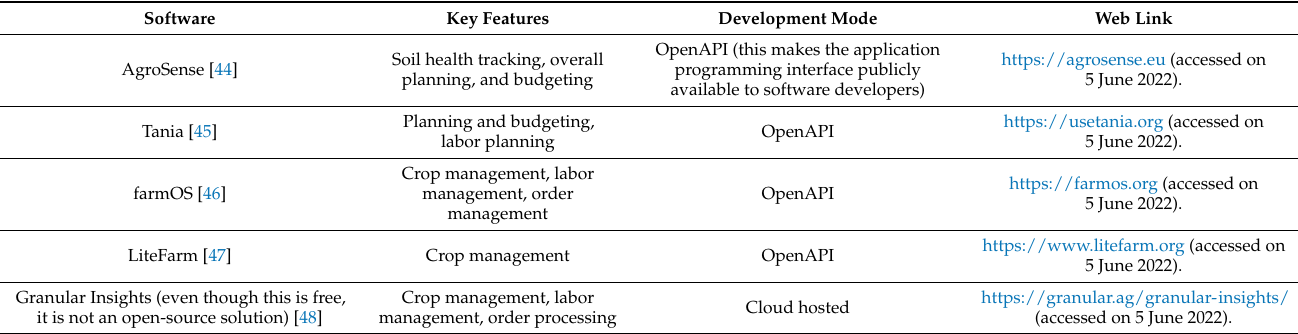
Table 5. Free and open-source precision farming